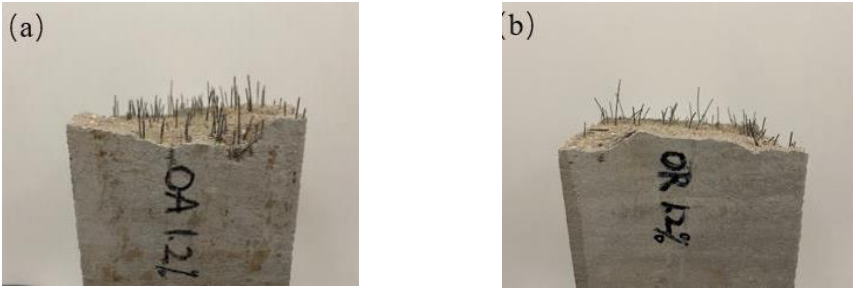
Figure 8. The specimen of the steel-fiber-reinforced cementitious composites. ( a ) The fractured surface of the ASFRC; ( b ) the fractured surface of the SFRC.